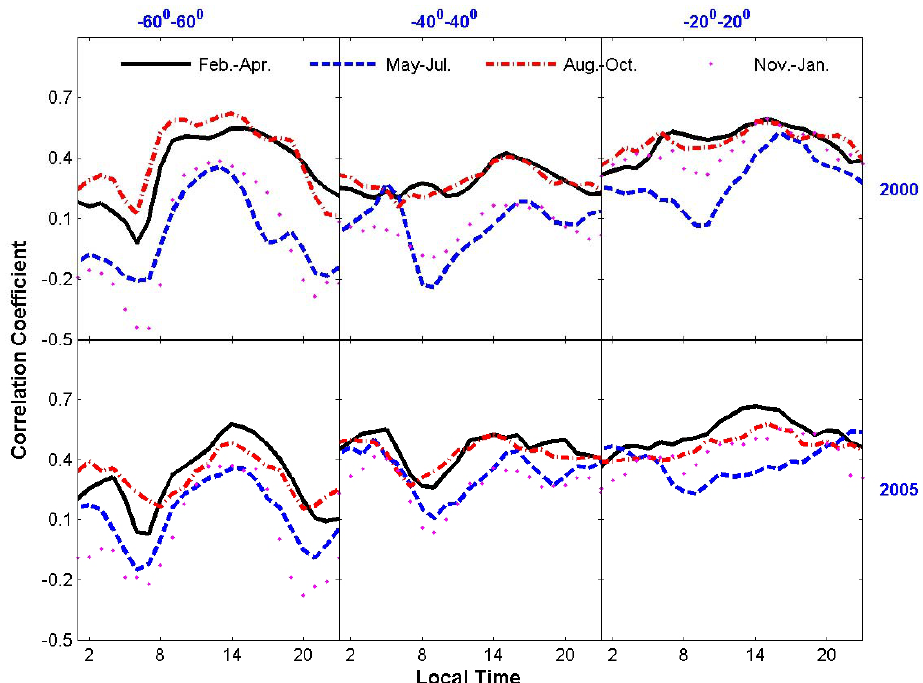
Fig. 2. (b) Local time variations of the correlation coefficients between magnetic conjugate points for the interval of February–April (solid lines), May–July (dashed lines), August–October(dashdot lines), and November–January (dots), respectively. The panels from left to right are for the magnetic conjugate points –60 ◦ –60 ◦ , –40 ◦ –40 ◦ , –20 ◦ –20 ◦ , respectively. The top panel is the situation of year 2000, while the bottom for 2005.